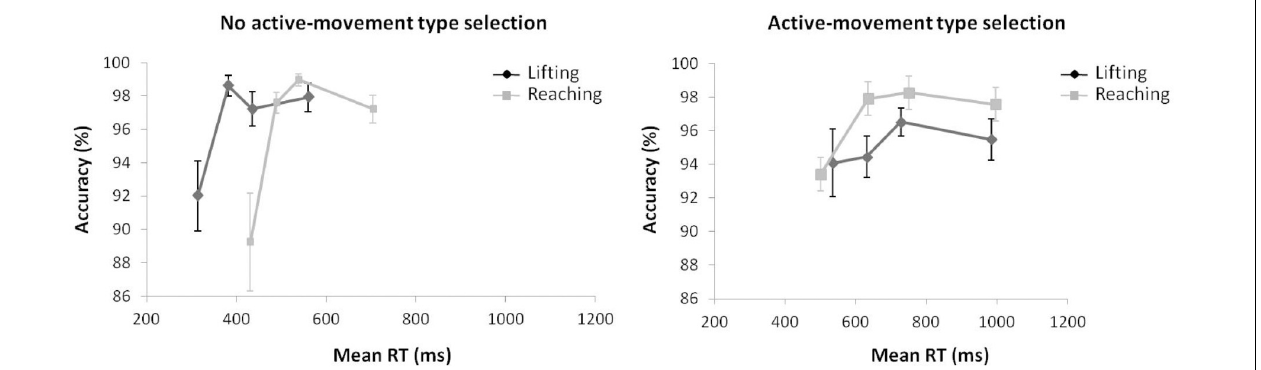
FIGURE 9 | Delta-plots showing conditional accuracy functions for incongruent trials as a function of response speed (expressed in response time quartiles) for lifting action (gray square) and reaching action (black circle), within the no active-movement type selection (Left) and active-movement type selection (Right) in Experiment 3. Error bars represent the standard error of the